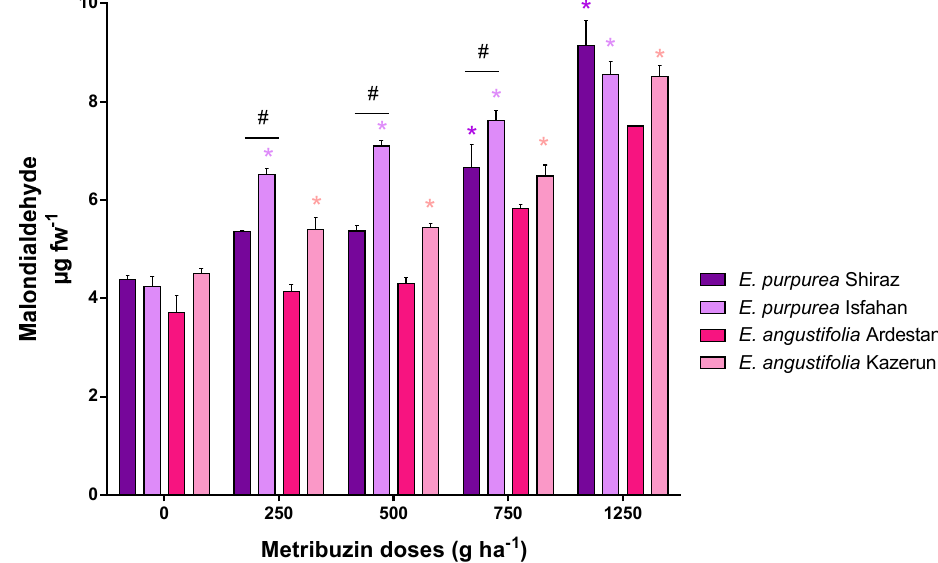
Figure 6. Effect of different metribuzin doses on malondialdehyde content of Echinacea purpurea and Echinacea angustifolia species. Data are shown as the mean ± SEM, and ordinary two-way ANOVA followed by Dunnett’s multiple comparisons test was used for statistical significance; * p < 0.005 vs. control (0 g ha − 1 metribuzin). Significant differences between Echinacea cultivars are indicated with #.